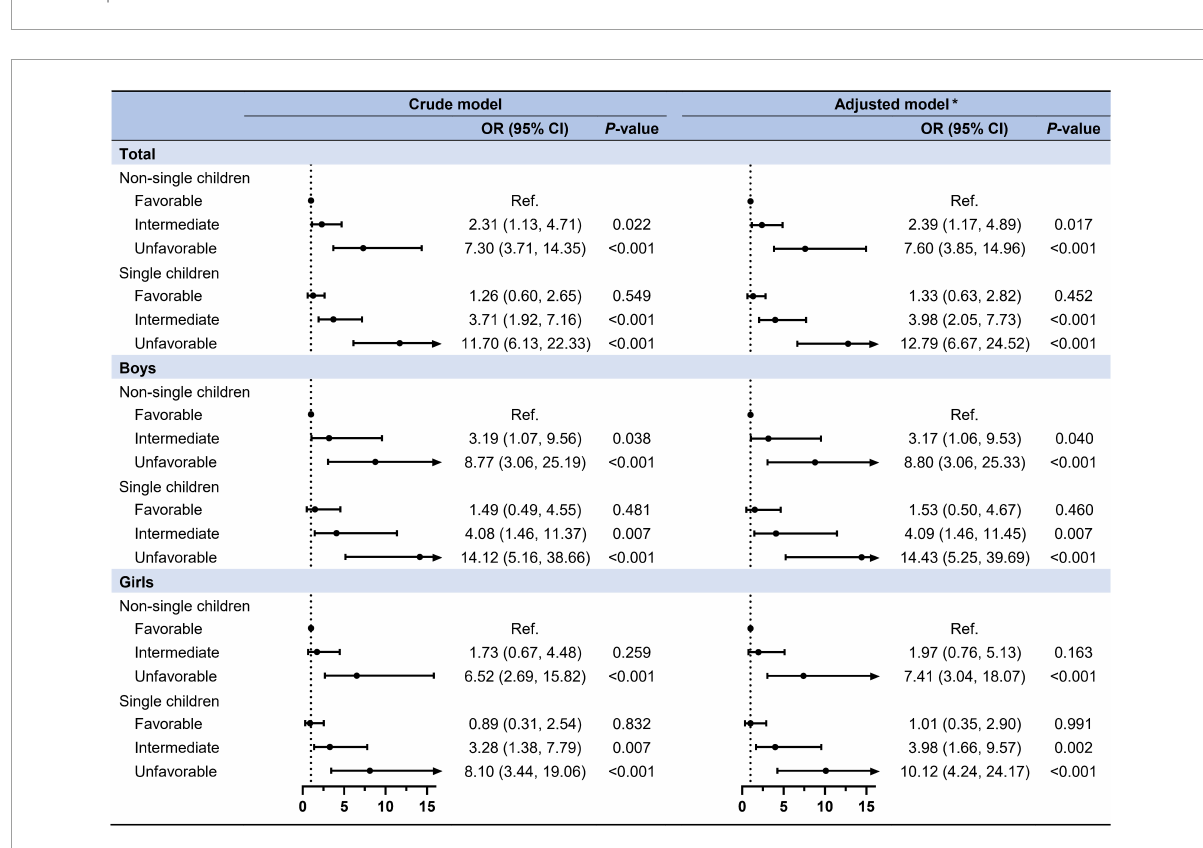
FIGURE3 Association between ideal lifestyle factors and clustered CMRFs in children and adolescents. ∗ Adjusted for age, residence, family history of diseases (obesity, hypertension, diabetes mellitus, and cerebrovascular disease), parental education level, parental tobacco, and alcohol consumption and the clustered effect of schools.